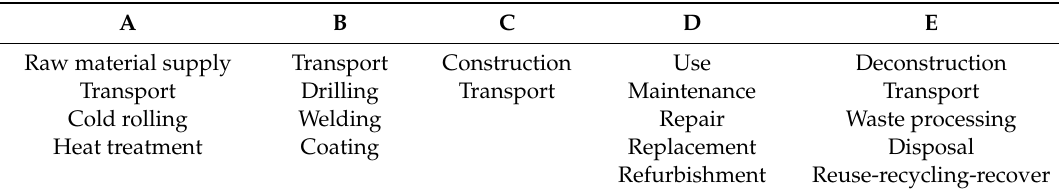
Table 1. Scope of the LCA of the steel o ffi ce